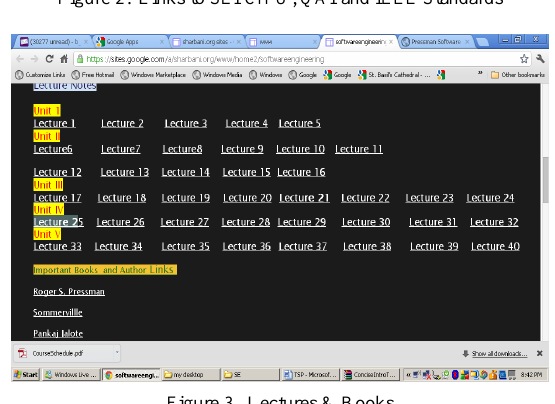
Figure 3. Lectures & Books